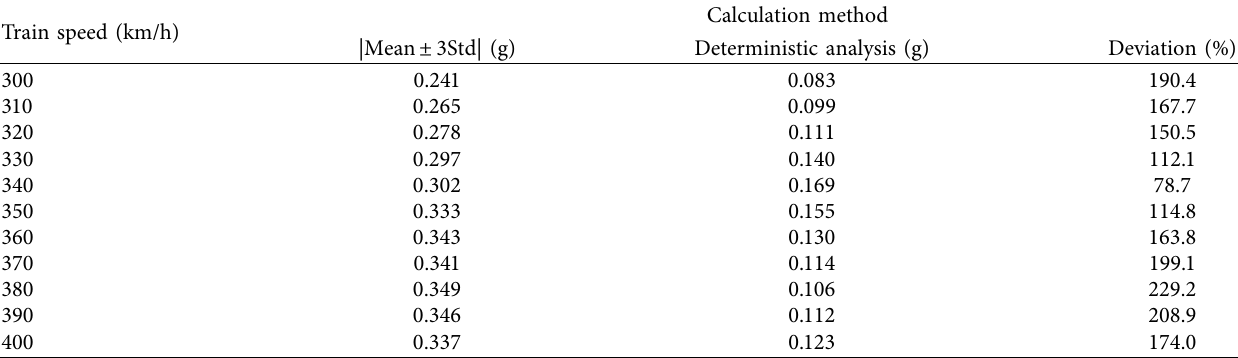
Table 4: Statistics of bridge midpoint maximum acceleration with different train speeds and calculation methods.